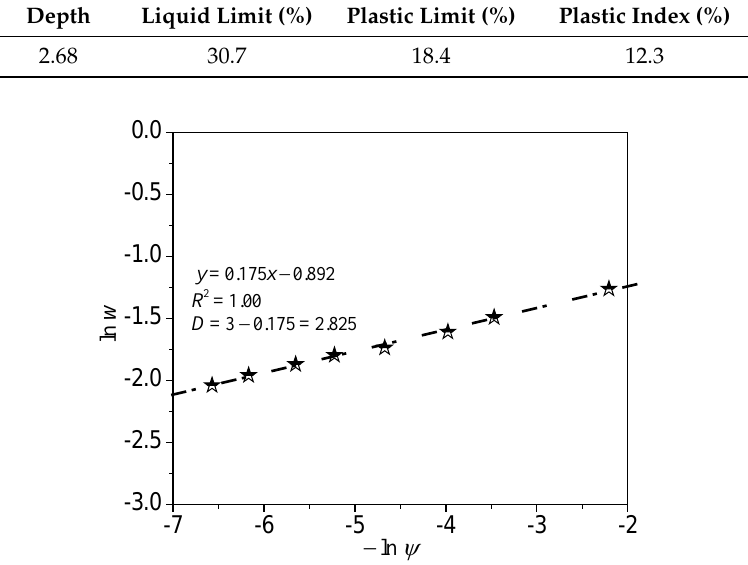
Figure 18. Determination of the values of fractal dimension at reference state through plotting experimental data of ln w against ( − ln ψ ) for loess with e 0 = 1.230.